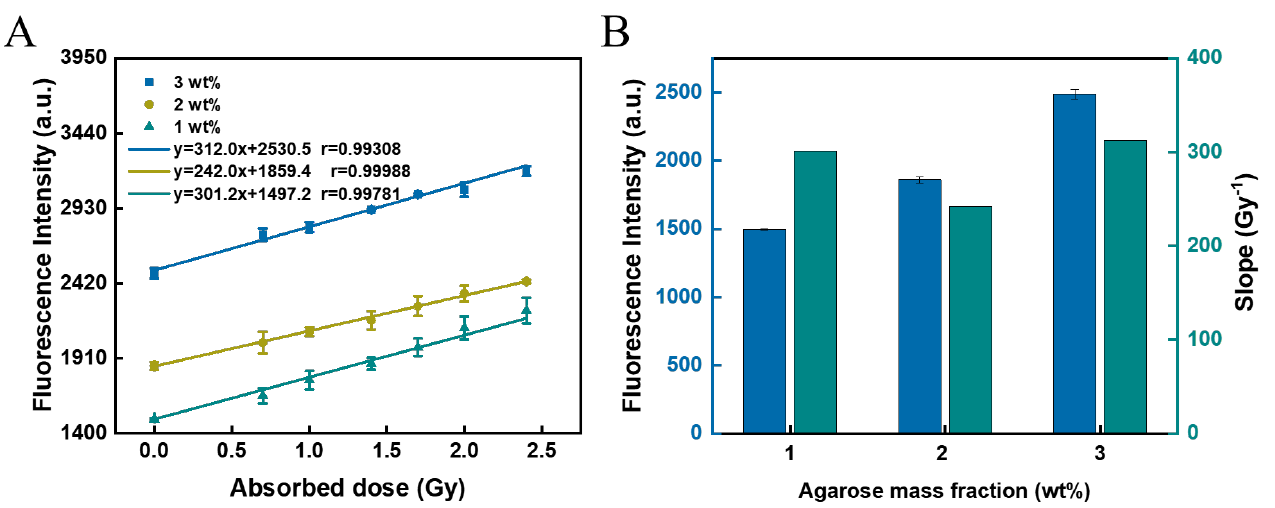
Figure 4. Effect of agarose mass fraction on the fluorescence intensity and linear relationship of hydrogel sensors. ( A ) Linear fitting of fluorescence intensity/absorbed dose curves with different agarose mass fractions (1 wt%, 2 wt%, and 3 wt%, respectively). ( B ) Effect of agarose mass fraction on fluorescence intensity and fitting slopes. The concentration of GNPs was 0.1 mM, and that of COU was 0.5 mM.